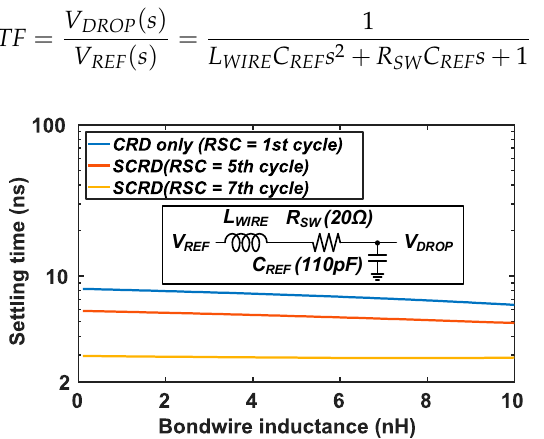
Figure 8. Settling time of the CRD from the worst signal-dependent voltage drop according to bondwire inductance ( L WIRE